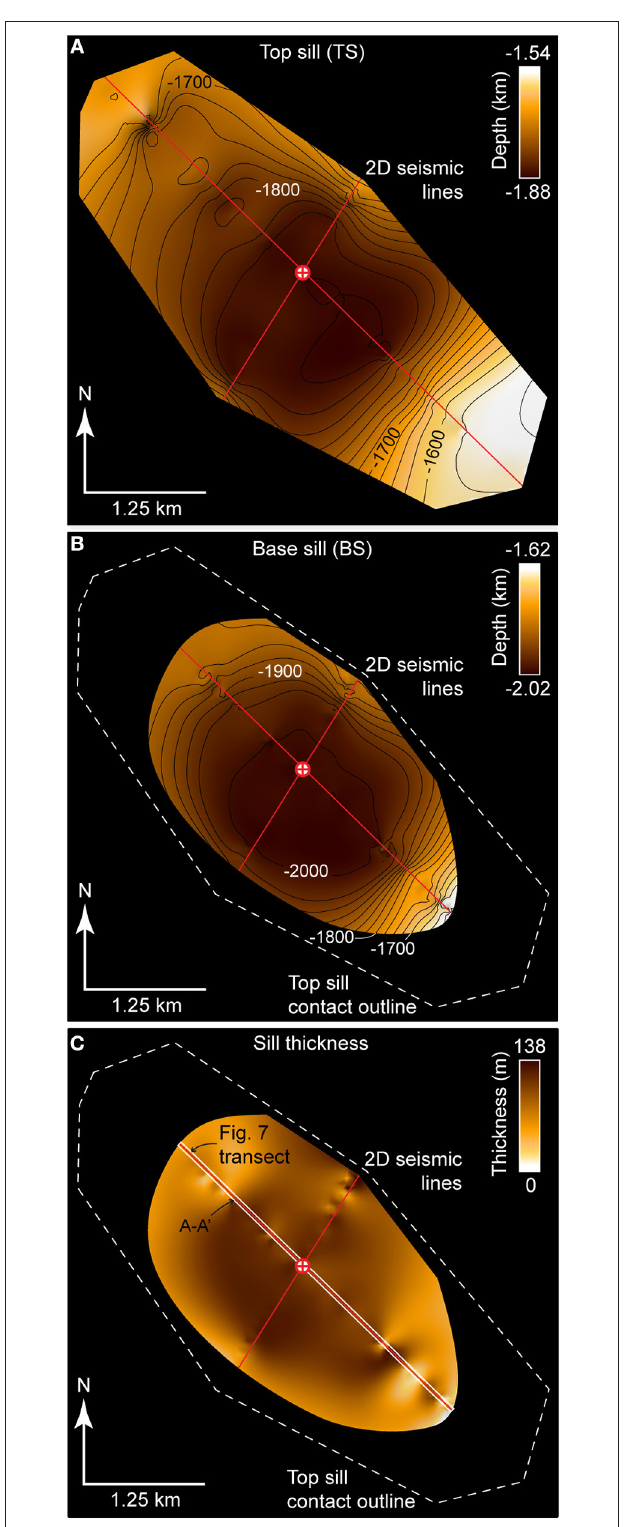
FIGURE 6 | (A,B) Depth-structure maps of top (TS) and base (BS) saucer-shaped sill reflections interpolated from interpretation of the sill on